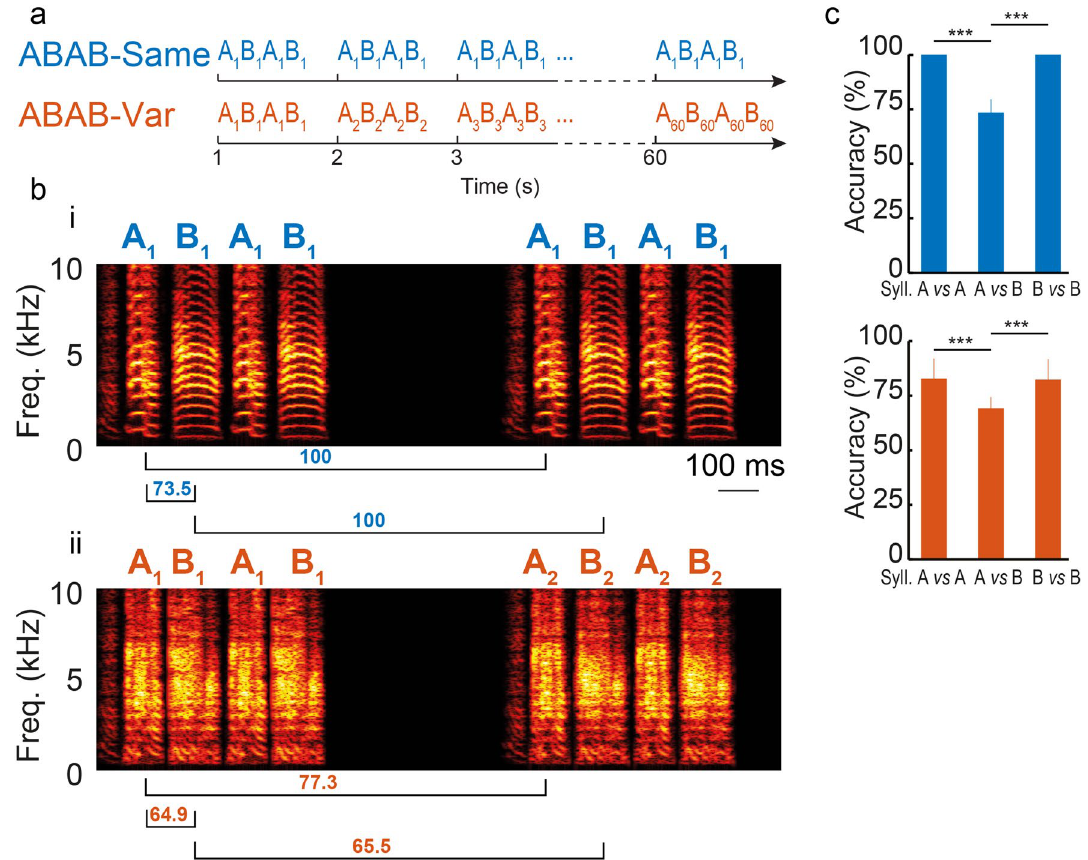
Figure 1. A single sequence or sequences with natural variations found in individual’s songs were used to build two series types: ABAB-Same and ABAB-Var series. ( a ) Schematic diagram of the structure of ABAB- Same (top) and ABAB-Var (bottom) series. A and B depict two syllable types used to form ABAB sequences. The ABAB-Same series consisted of 60 repetitions of a single ABAB sequence while the ABAB-Var series consisted of 60 distinct renditions of a given ABAB sequence. These renditions called sequence “variants” were labelled as